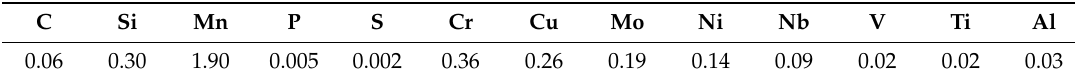
Table 1. Chemical compositions of the test steel (wt. %).